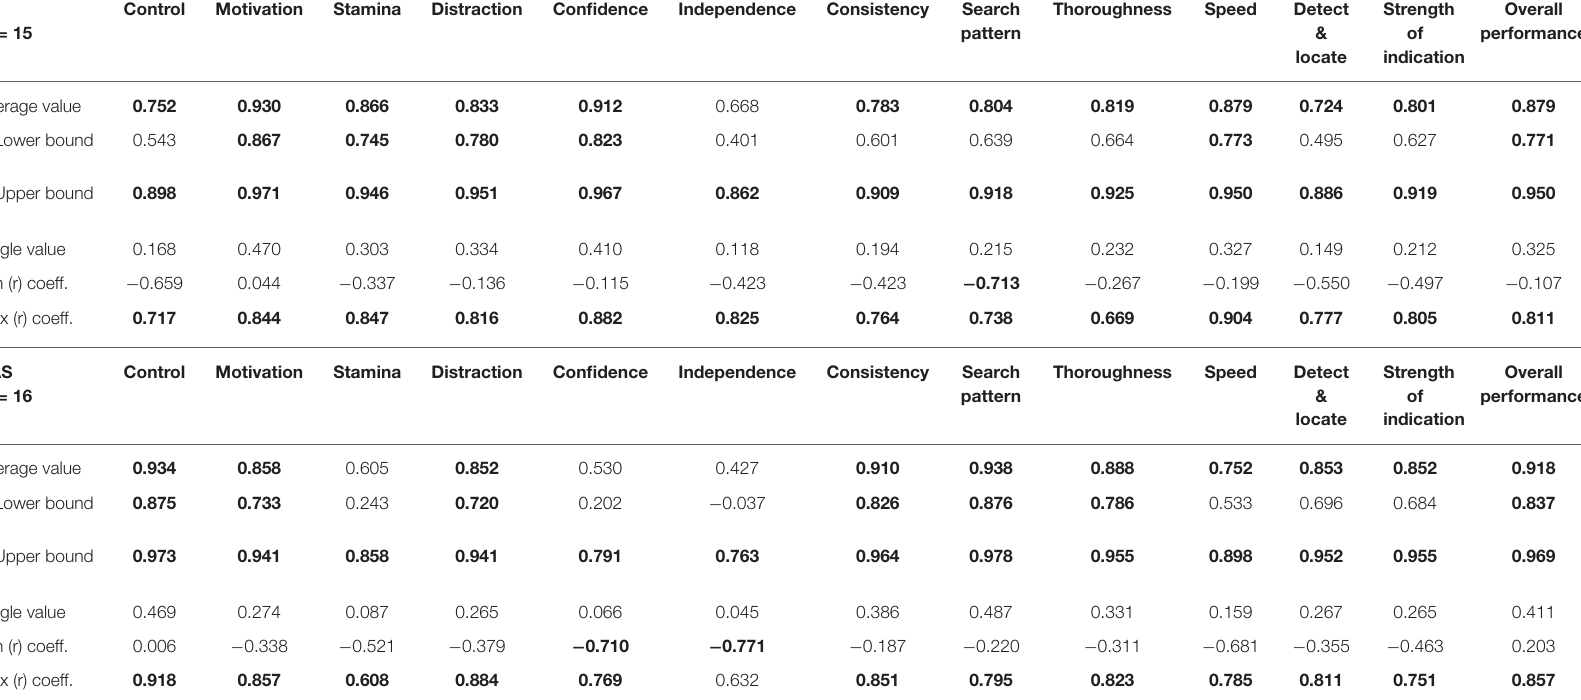
TABLE 2 | Reliability of